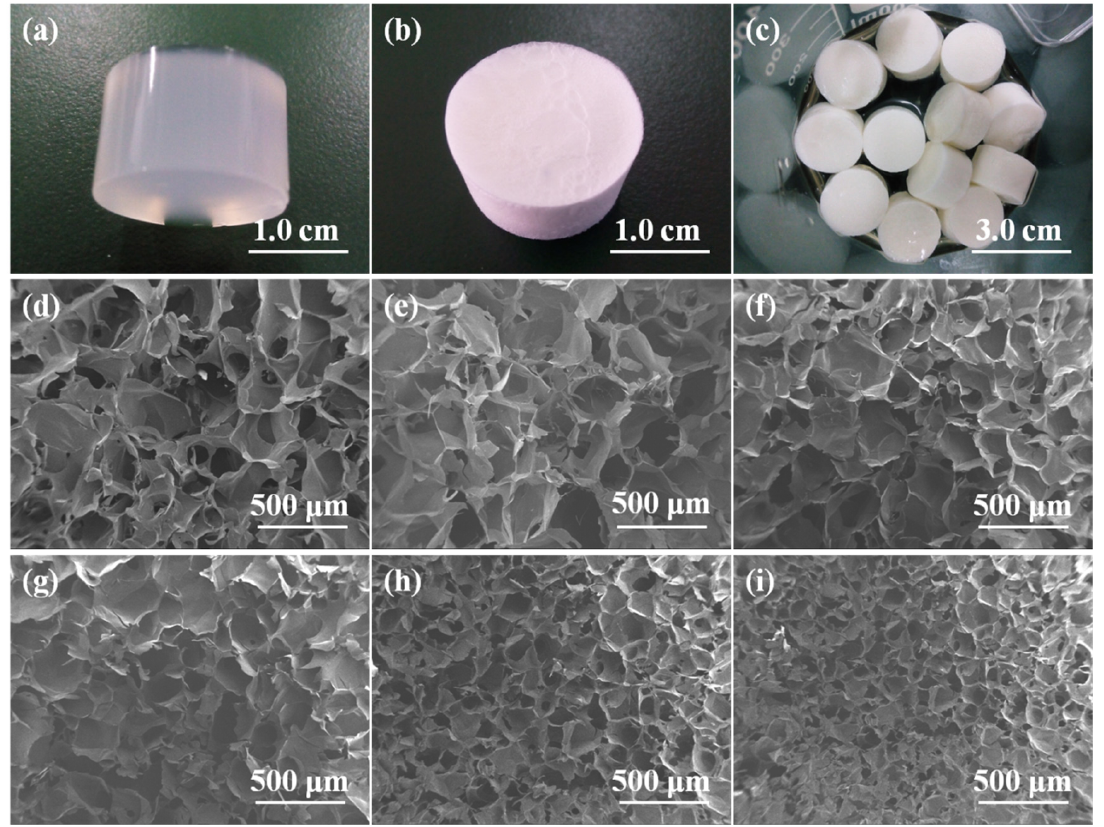
Figure 3. Photographs of ( a ) un-dried Alg/BCNs-CS-GT composite scaffolds, ( b ) dry Alg/BCNs-CS-GT composite scaffolds and ( c ) Alg/BCNs-CS-GT composite scaffolds in the LBL electrostatic assembly process; SEM images of Alg/BCNs-CS-GT composite scaffolds with various amount of BCNs: ( d ) 0, ( e ) 0.1% ( w / v ), ( f ) 0.2% ( w / v ), ( g ) 0.3% ( w / v ), ( h ) 0.4% ( w / v ) and ( i ) 0.5% ( w / v ).